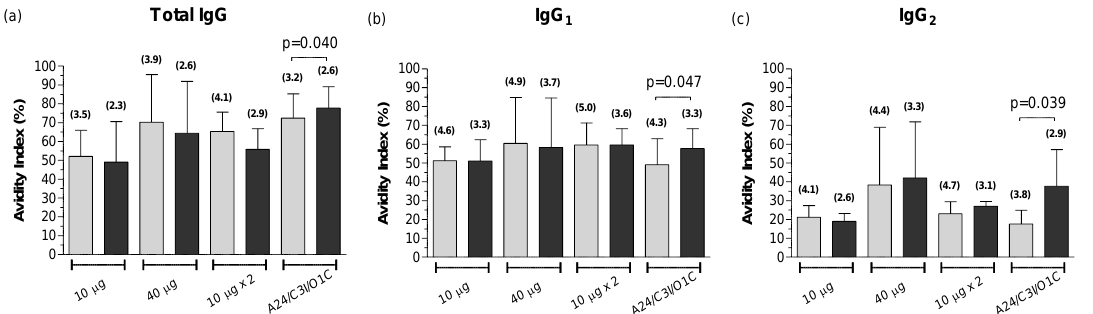
Figure 7. Mean avidity of the FMDV-specific IgG antibodies against the A24/Cruzeiro and A/Arg/01 strains at 30 dpv. The avidity for FMDV-specific whole IgG ( a ), IgG1 ( b ), and IgG2 ( c ) antibodies were measured by avidity ELISA against A24/Cruzeiro (light bars) and A/Arg/01 strains (dark bars) for experimental group. Results are expressed as the AI and bars represent the mean AI ± SD. Values in parentheses represent the corresponding ELISA mean antibody titers expressed as log 10 for each experimental group. Statistical differences were determined by a paired t -test.